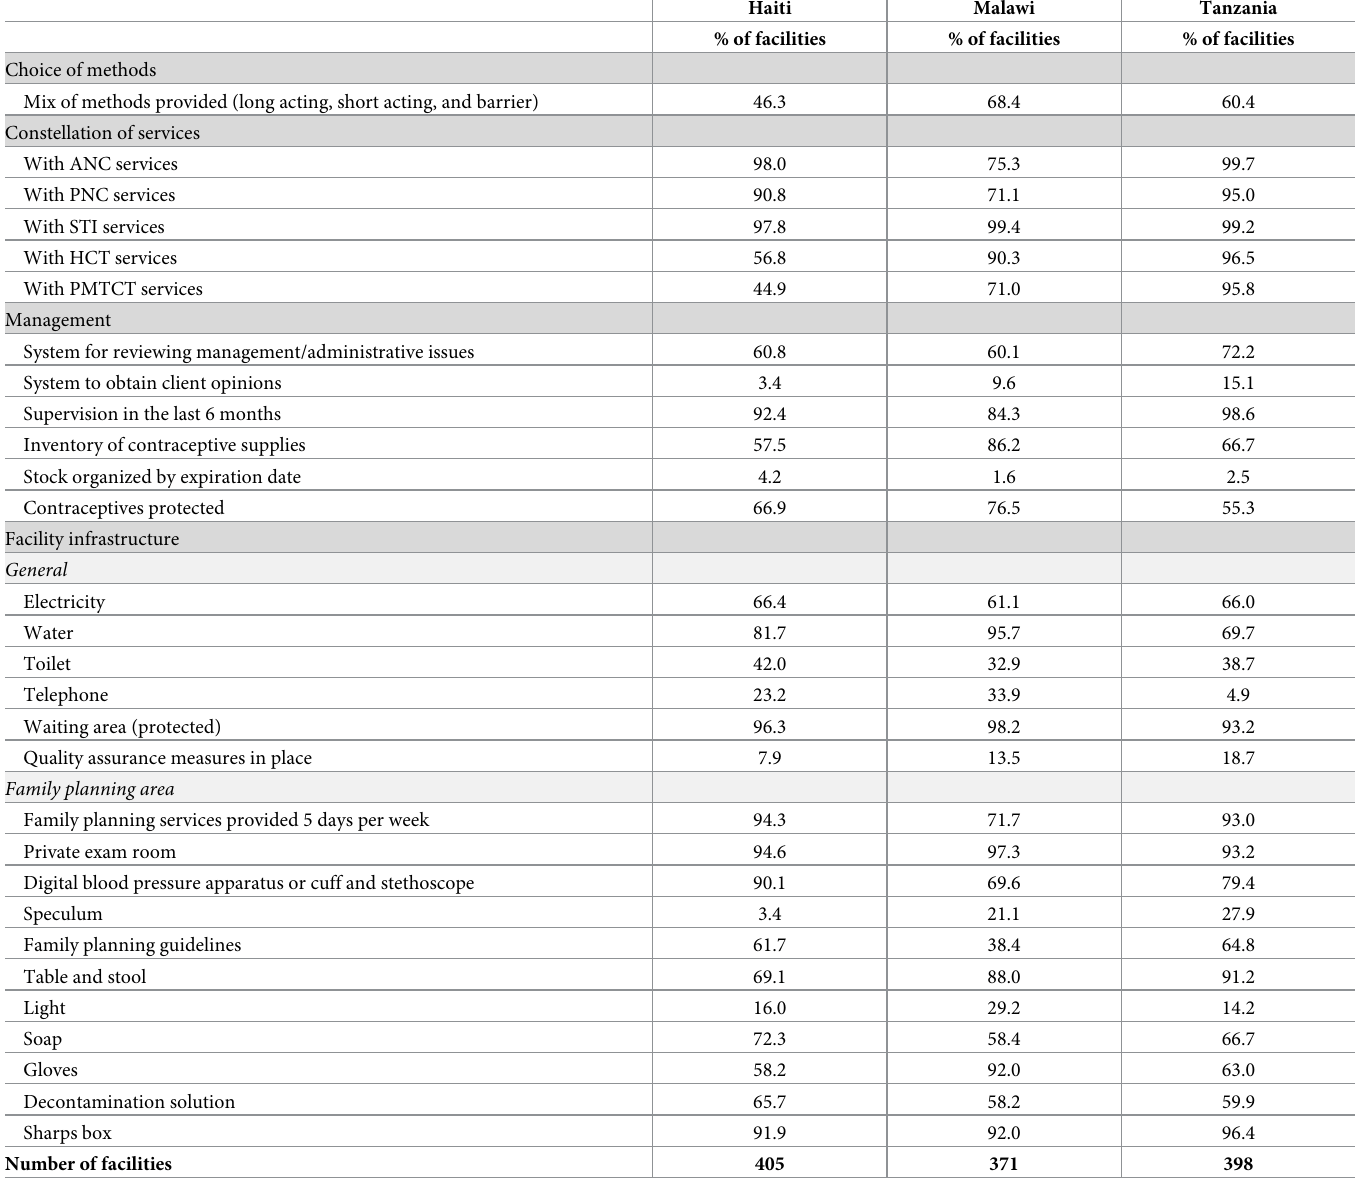
Table 2. Percentage of facilities providing family planning with structure quality of care